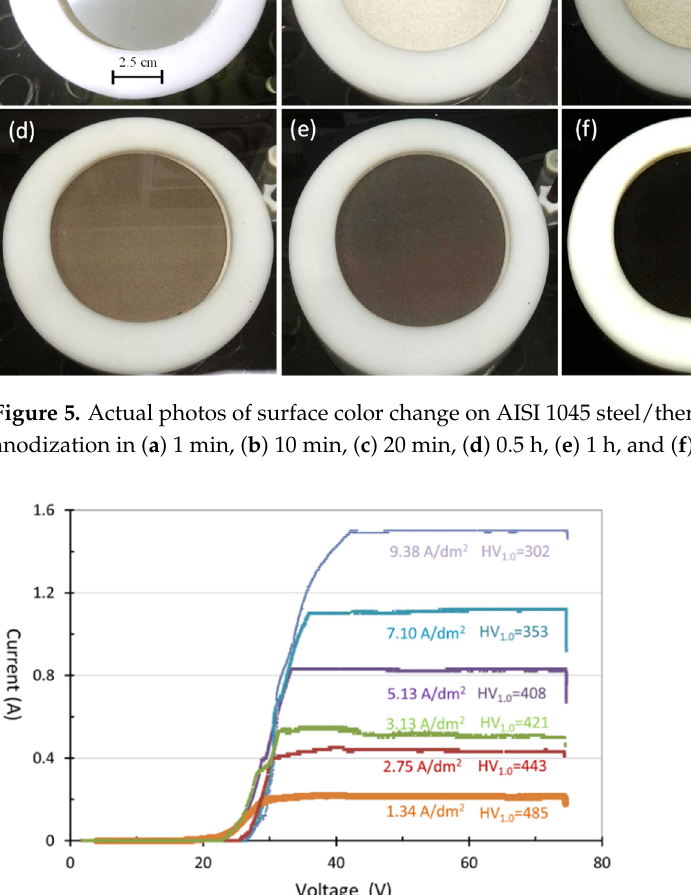
Figure 6. I-V curves of hard anodization with current densities of 1.34, 2.75, 5.13, 7.10, and 9.38 ASD.